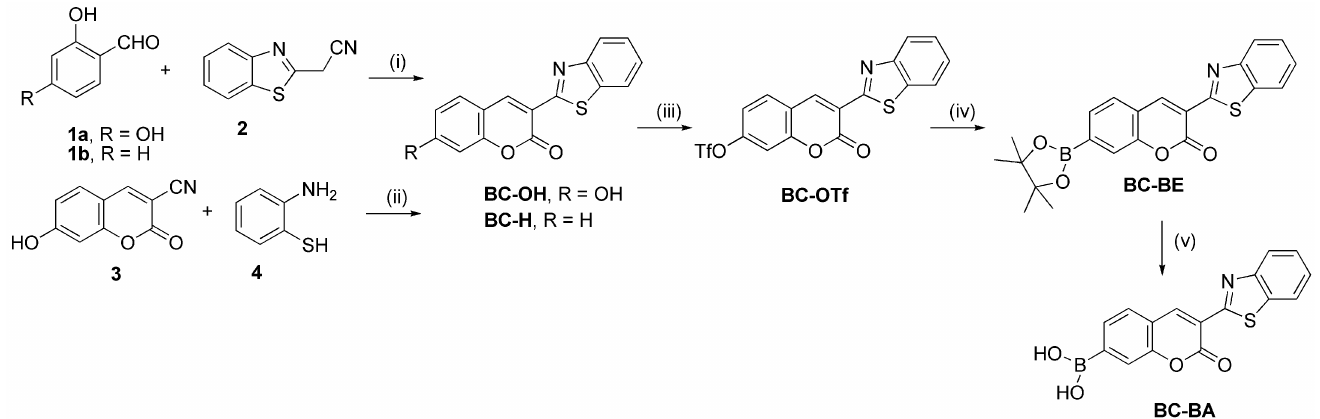
Table 1. Photophysical properties of studied